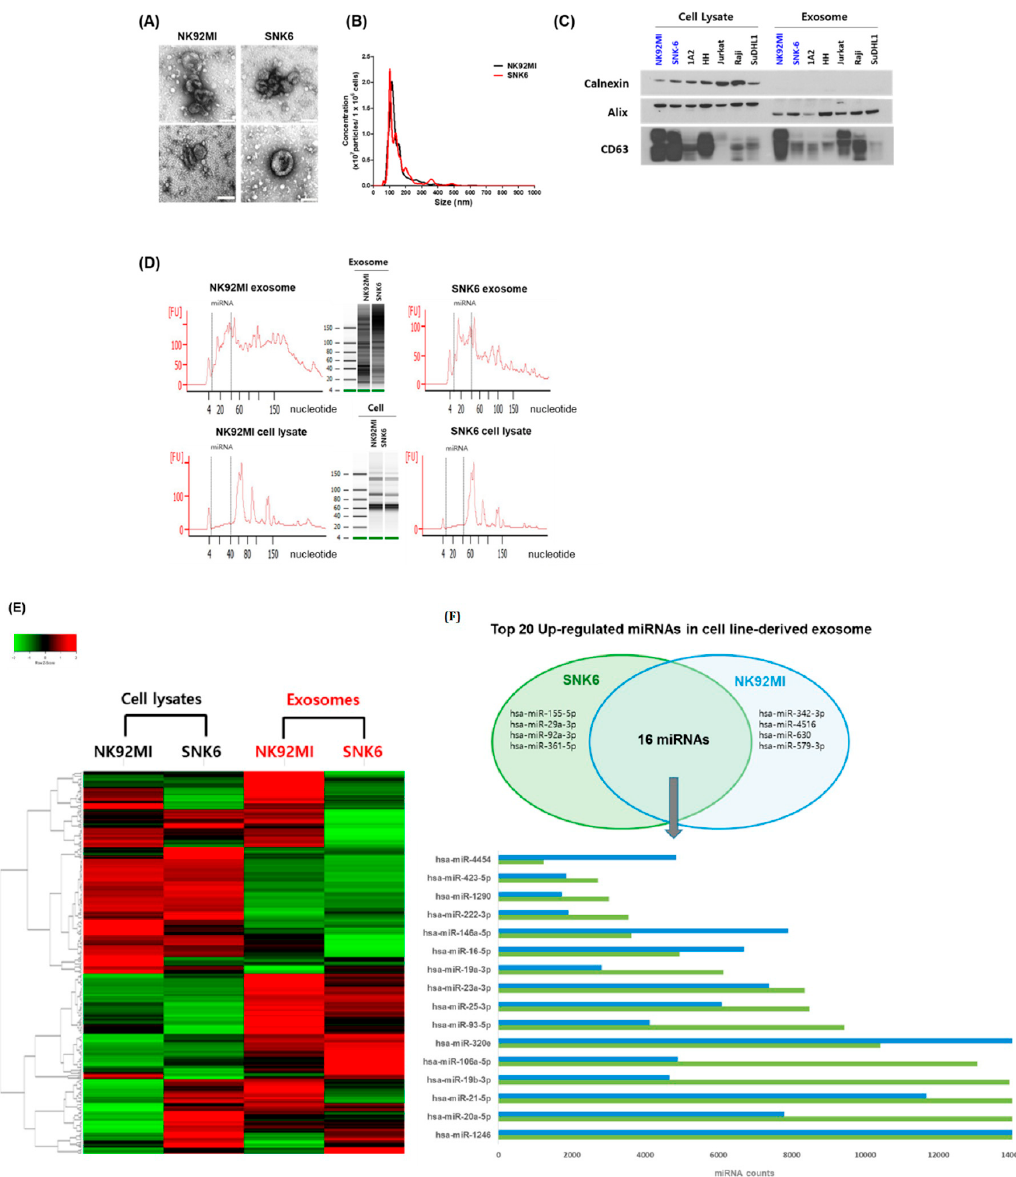
Figure 2. Characterization and miRNA analysis of exosomal and cellular miRNA in NKTL cell lines. ( A ) Exosomes were isolated from lymphoma cell lines by ExoQuick and the size and concentration of the exosomes were assessed by transmission electron microscopy. Scale bar = 100 nm. ( B )